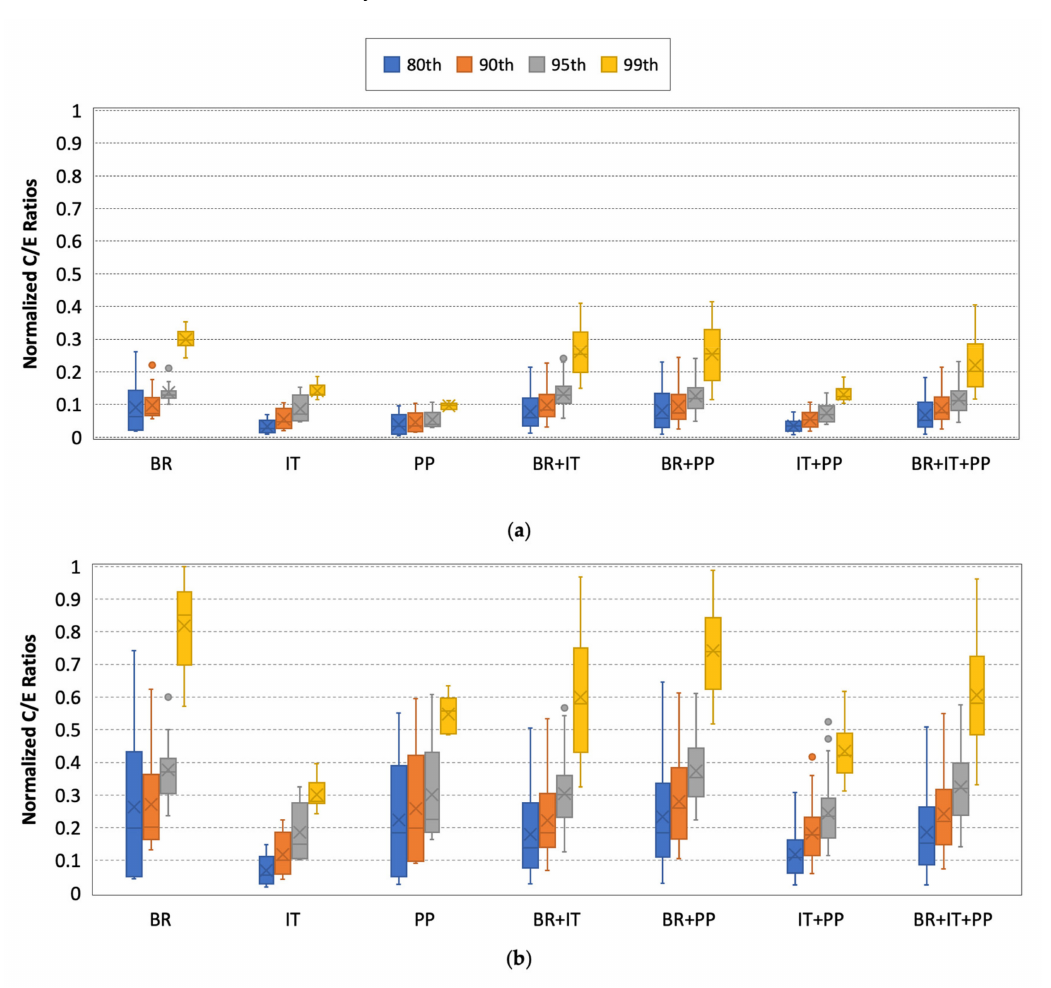
Figure 6. Box plot of the cost-effectiveness of the ( a ) optimistic estimate and ( b ) pessimistic estimate optimal